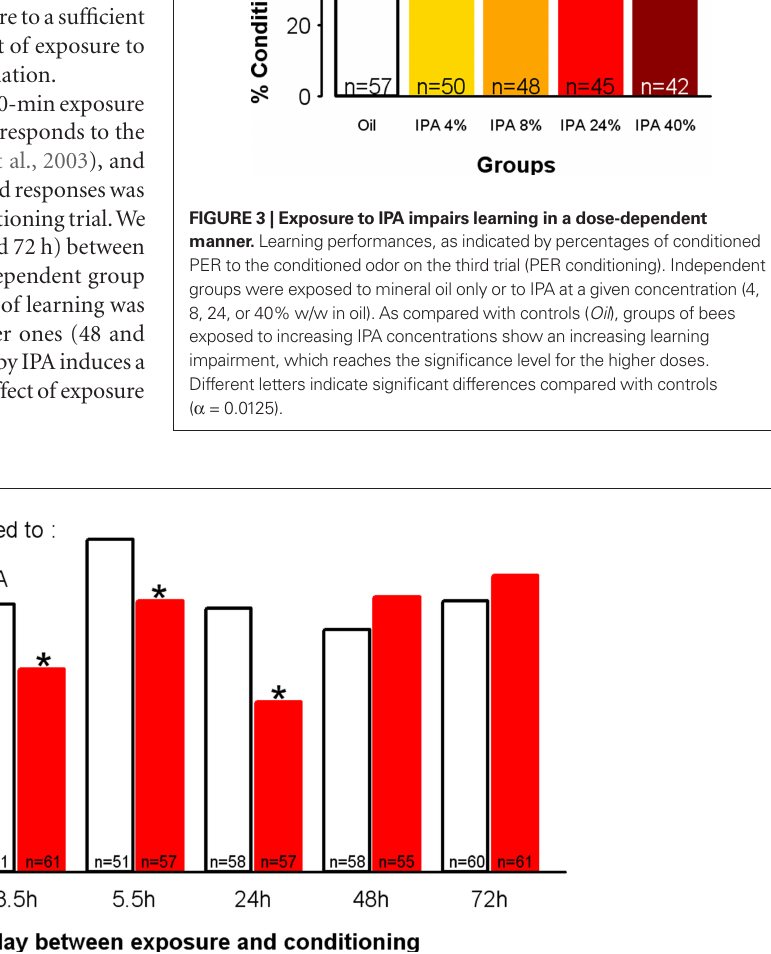
Figure 4 | iPA impairs learning up to 24 h after exposure. Learning performances, as indicated by percentages of conditioned PER to the conditioned odor on the third trial (PER conditioning), after a delay between exposure (either to IPA at the 24% concentration or to mineral oil) and olfactory